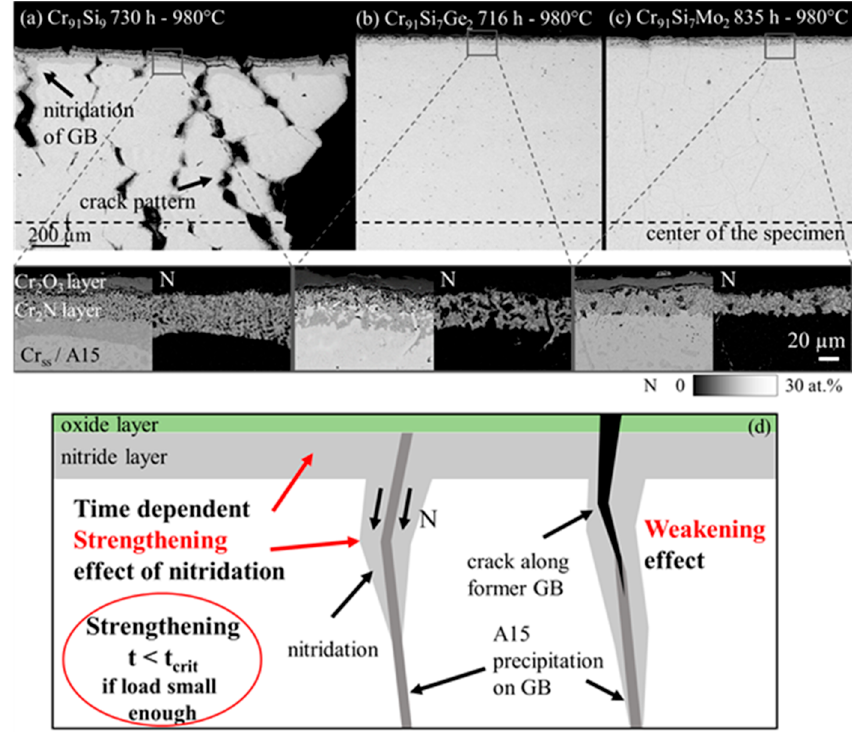
Figure 5. BSE-images of the cross sections of all alloys tested at 50 MPa with details of the formed surface layer and corresponding N element distribution maps. ( a ) Cr 91 Si 9 , ( b ) Cr 91 Si 7 Ge 2 and ( c ) Cr 91 Si 7 Mo 2 . ( d ) Schematic drawing of nitridation of the specimen surface, along grain boundaries (GB) and crack edges that can be beneficial due to a volume increase. At higher loads, embrittlement by nitridation results in much lower strain to failure.